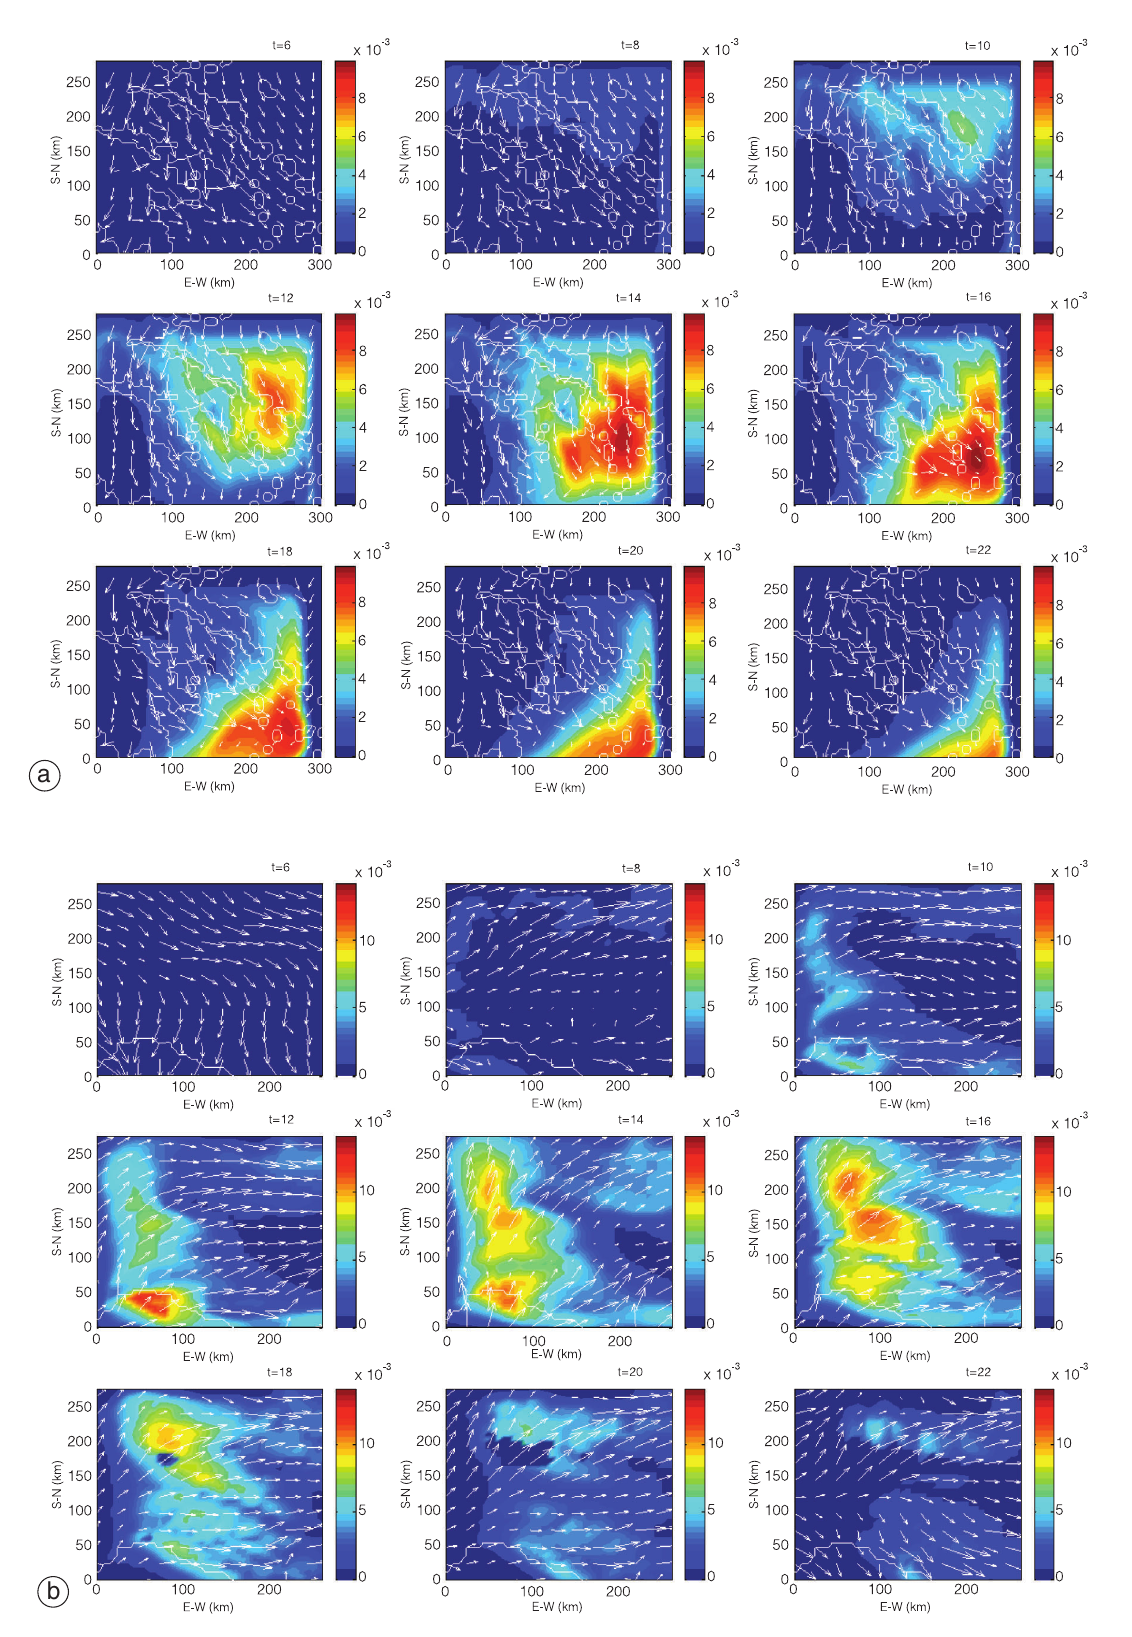
a Fig. 4a,b. Evolution of S 1O3 CO for the domain of: a) Athens; b) Milan.